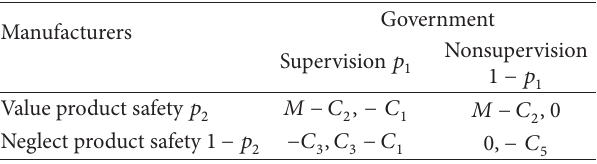
Table 1: Game matrix of the government and manufacturers.